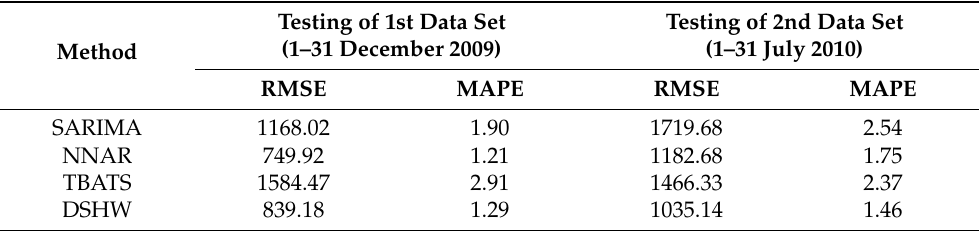
Table 2. RMSE and MAPE for one-step-ahead forecasts for the testing data of the two data sets of hourly electricity load in Malaysia, obtained by SARIMA, NNAR, TBATS, and DSHW.